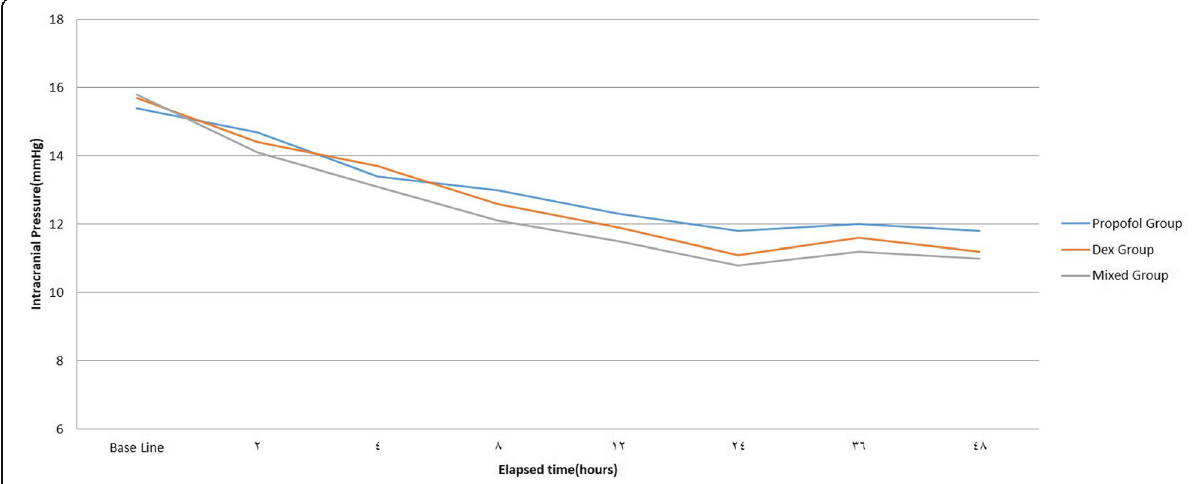
Fig. 6 Intracranial pressure changes in the studied